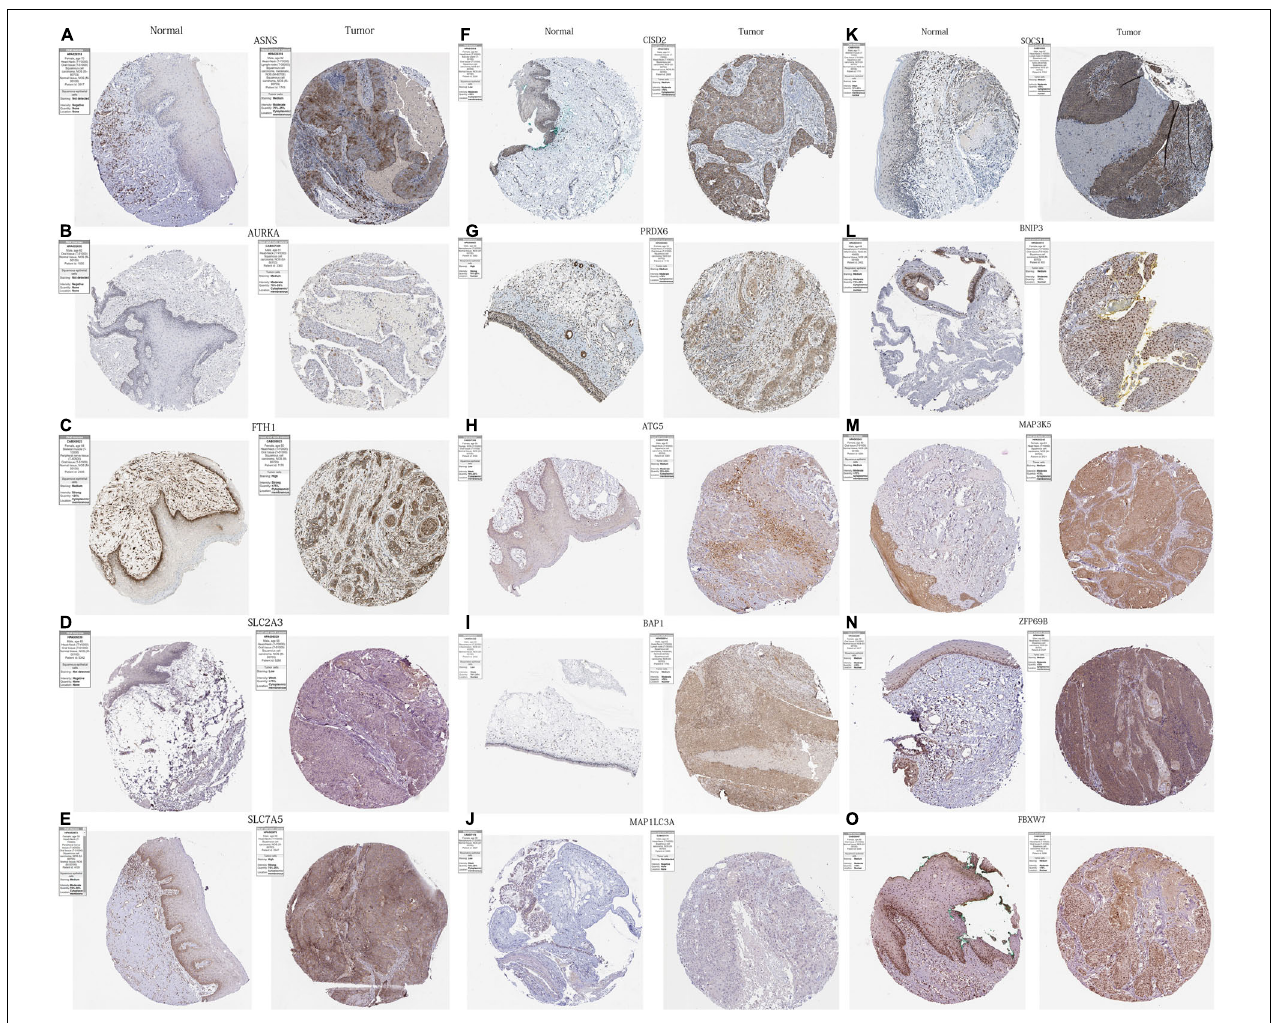
FIGURE 13 | Immunohistochemistry images of 15 PR-DE-FRGs in HNSCC and normal tissues of the head and neck. (A) ASNS, (B) AURKA, (C) FTH1, (D) SLC2A3, (E) SLC7A5, (F) CISD2, (G) PRDX6, (H) ATG5, (I) BAP1, (J) MAP1LC3A, (K) SOCS1, (L) BNIP3, (M) MAP3K5, (N) ZFP69B, and (O) FBXW7.